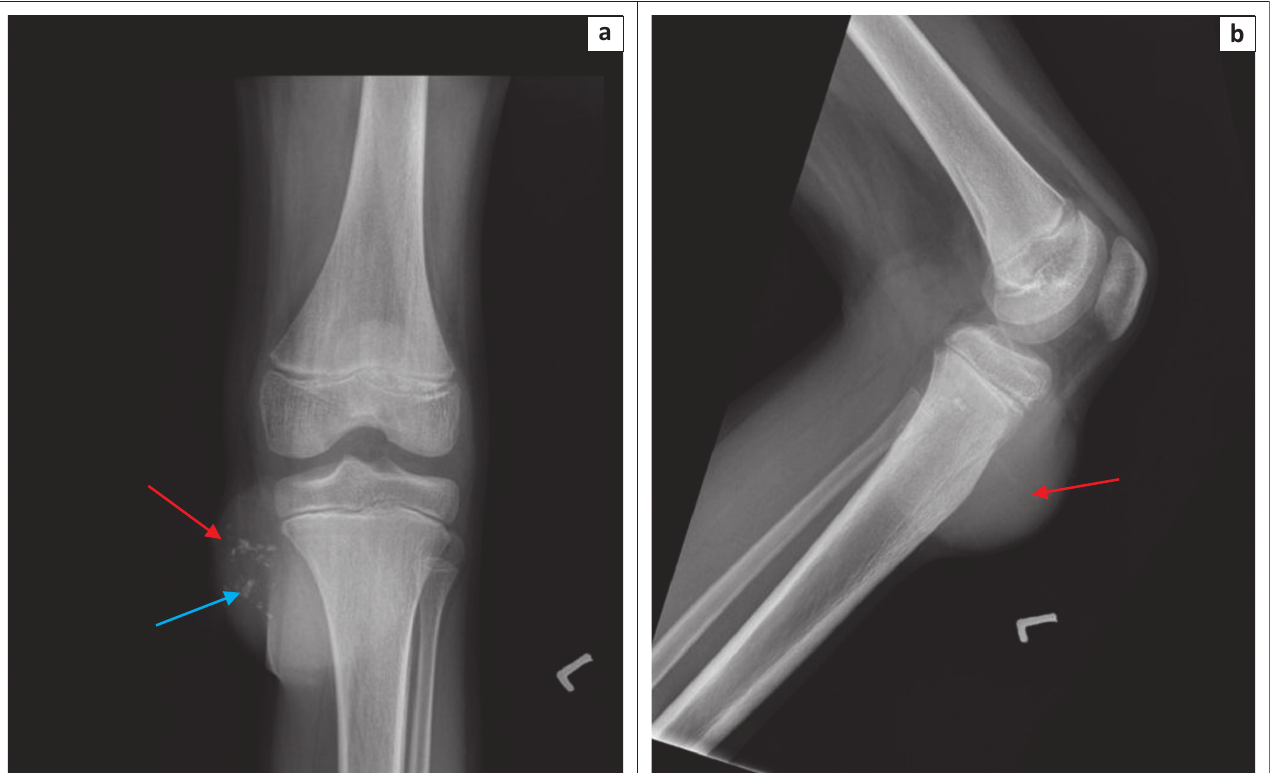
FIGURE 1: Anteroposterior (a) and lateral (b) radiographs of the left knee display a soft-tissue mass anteromedial to the proximal tibia (red arrows) of an adolescent patient. Note the coarse calcifications (blue arrow, AP view).